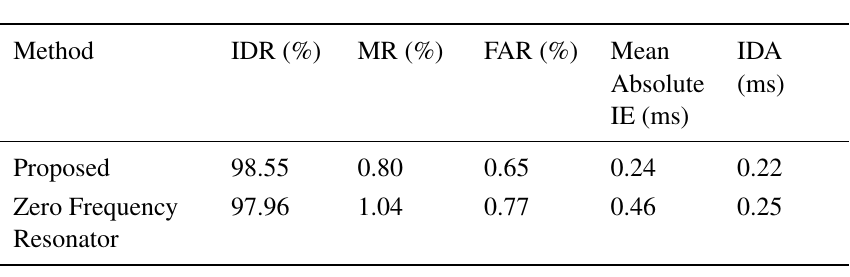
Table 1. Performance comparison of epoch detection methods on three male and three female speech signals taken from the CMU-Arctic